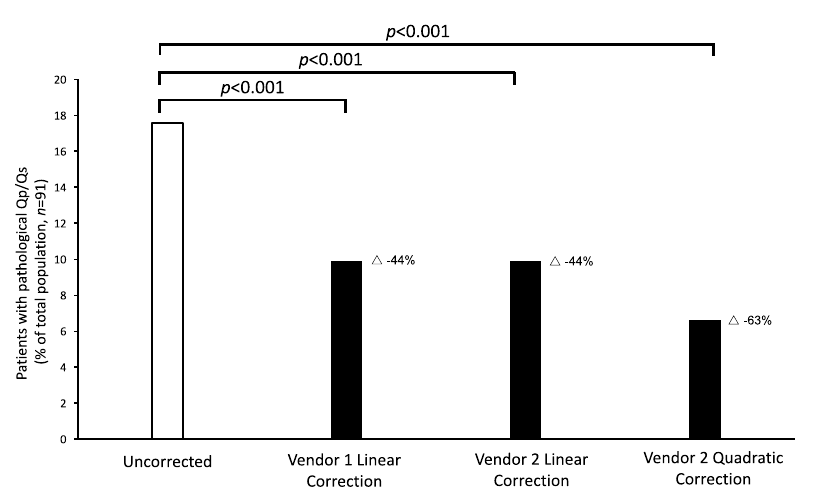
Figure 2. Reduction of the number of patients with pathological Qp/Qs following stationary tissue background correction ( n = 91). Stationary tissue background correction reduces the number of patients with pathological Qp/ Qs. Triangle denotes reduction in patients with pathological Qp/Qs in percent. P -values denote McNemar’s